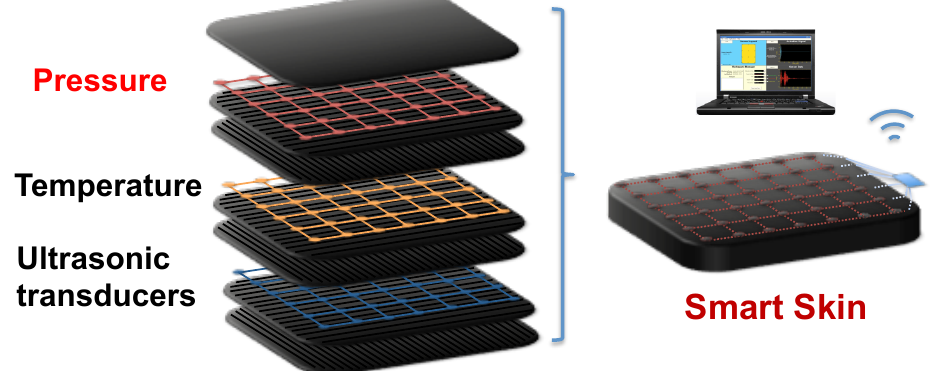
Figure 1. Schematic overview of stretchable pressure sensor network integrated into smart skin